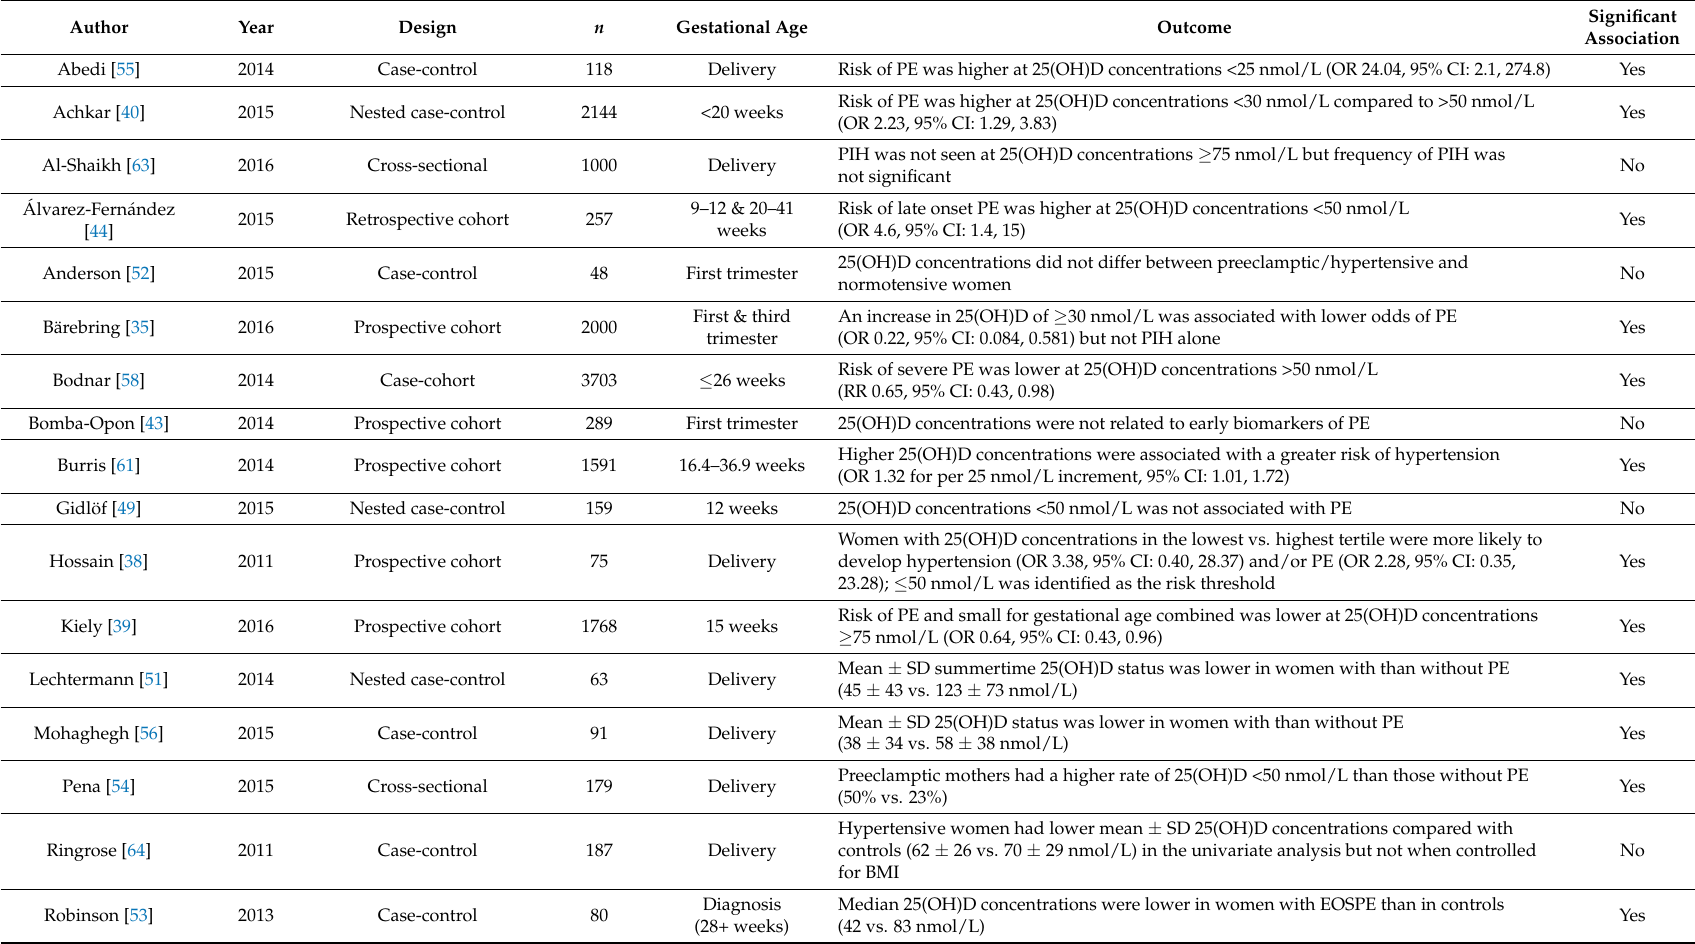
Table 1. Observational studies of serum 25(OH)D and risk of hypertensive disorders in